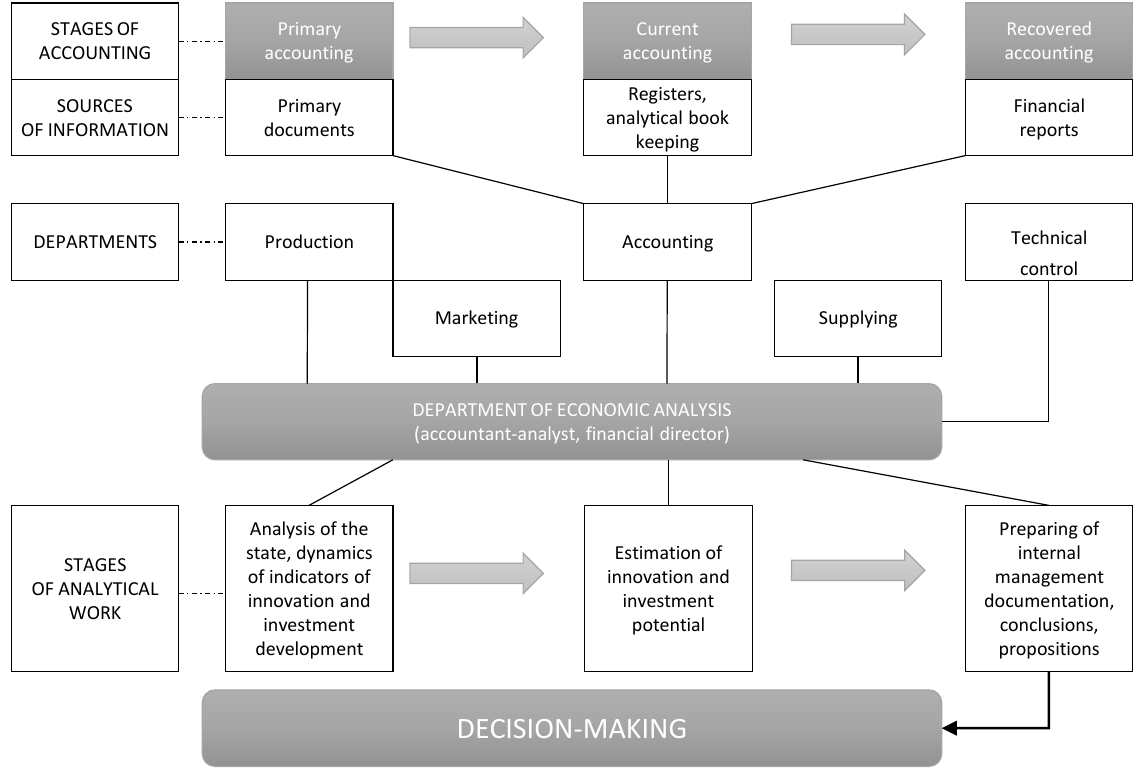
Figure 1. The scheme of formation of accounting and analytical information on innovation and investment activity of the